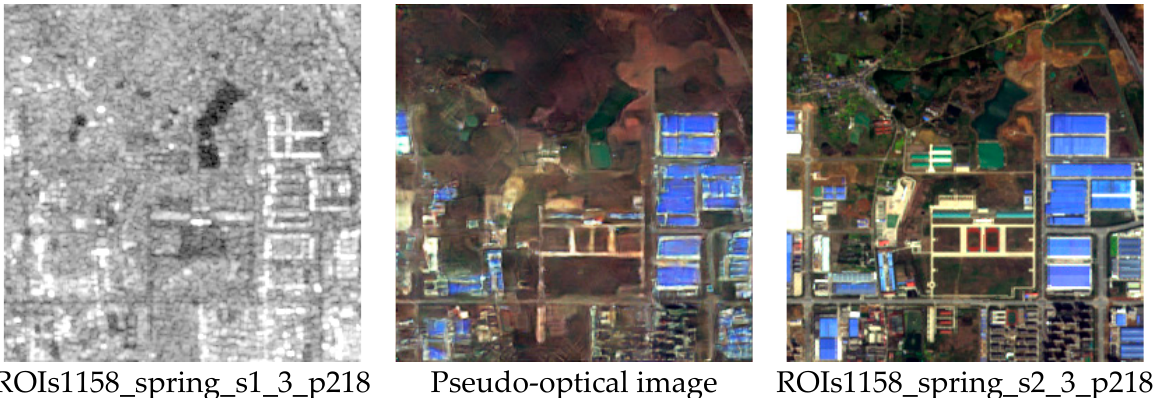
Figure 1. High-quality image translation results obtained with our method. The pseudo-optical image is the image generated from the SAR image through our method.